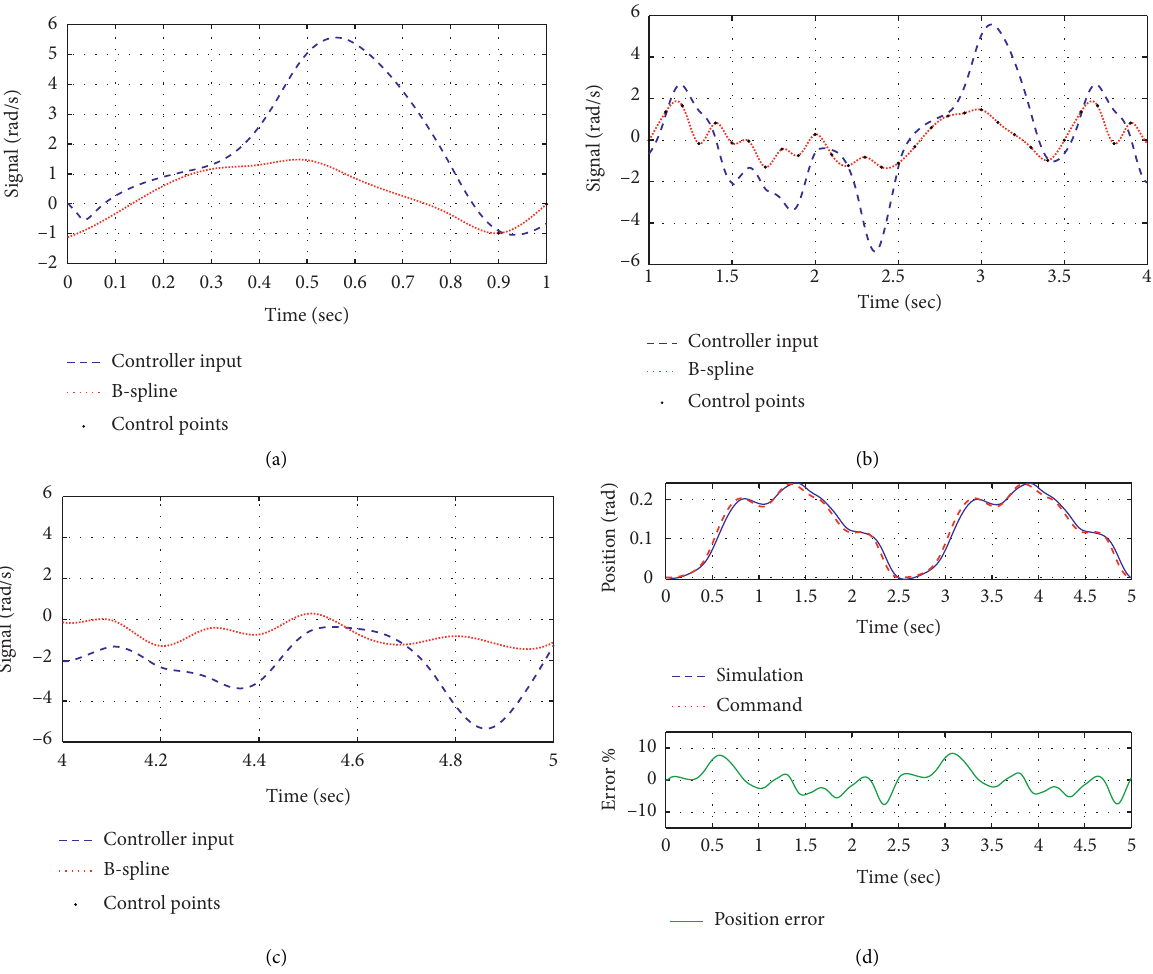
Figure 3: Input modification scheme of manipulator controller based on conventional B-spline optimization (control points with nonuniform distribution). (a) Controller input and compensatoroutput in part1. (b) Controller input and compensatoroutput in part2. (c)Controller input and compensator output in part 3. (d) Comparison and error of reference position and measurement